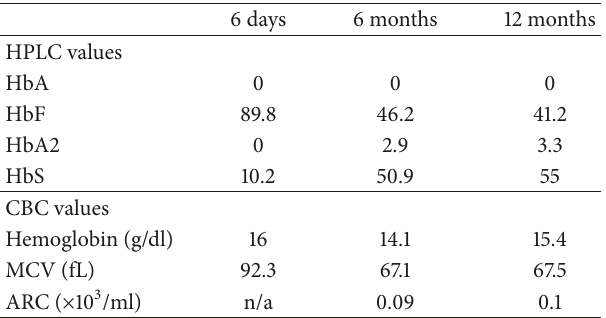
Table 1: HPLC and CBC results in patient. Table 2: Globin gene comprehensive